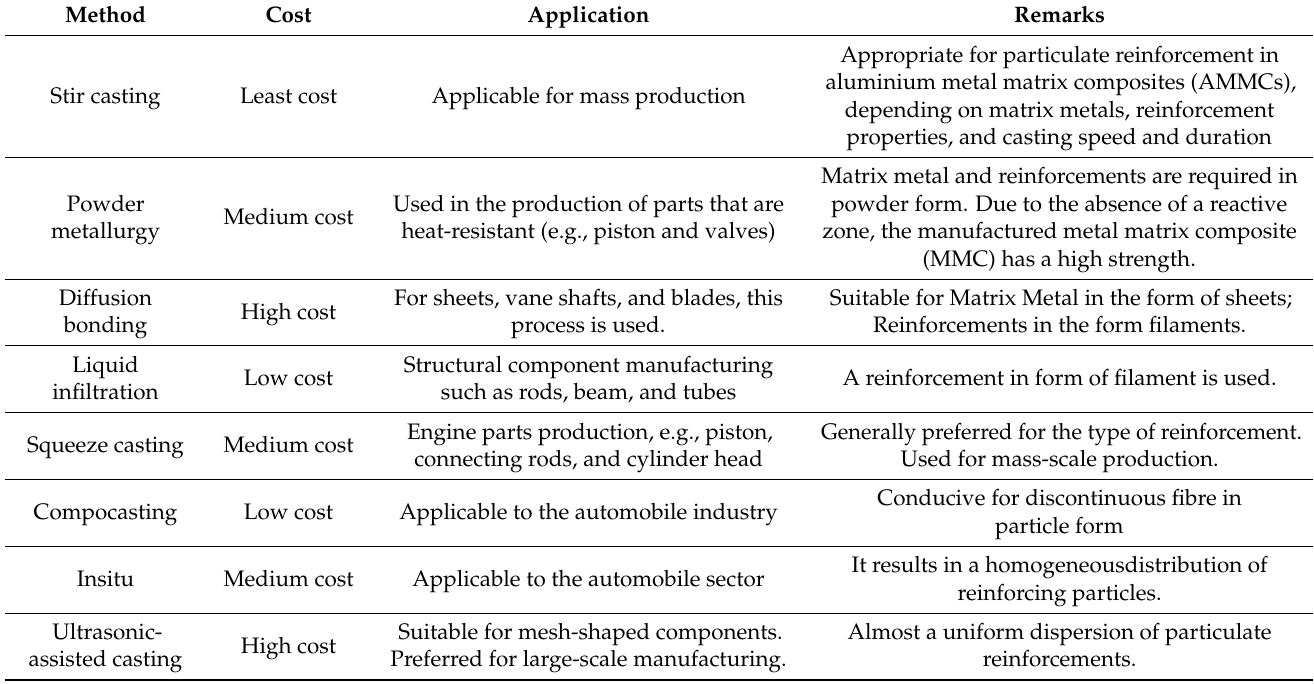
Table 1. Various fabrication techniques with unique features and costs